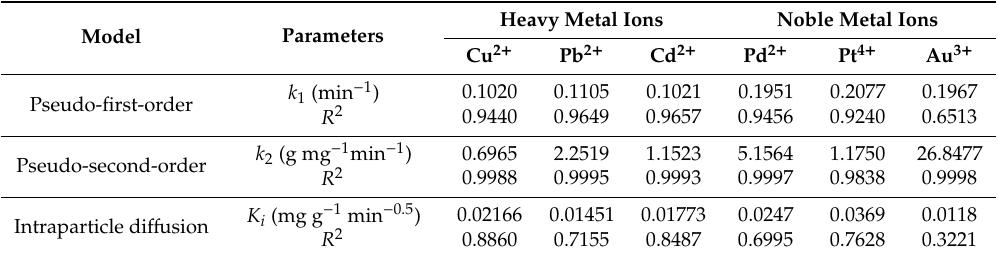
Table 2. Kinetic parameters for the adsorption of HM and NM ions onto DTC-g-PE-DA@GB@PU and PE-DA@GB@PU, respectively (25 ◦ C).